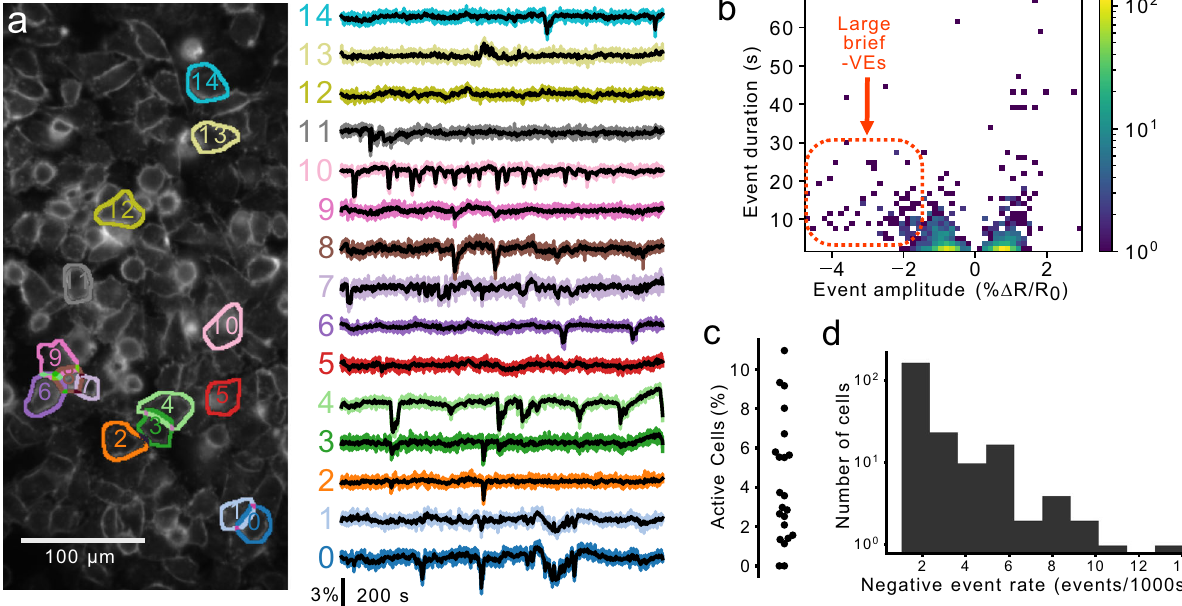
Fig. 3 A subset of MDA-MB-231 cells exhibit V m fl uctuations. a The ratio of Di-4-AN(F)EP(F)PTEA fl uorescence ( Δ R / R 0 ) was imaged at 5 frames/s in cultured MDA-MB-231 cells. The Δ R / R 0 time series extracted from the segmented cells (right) reveals heterogeneous V m fl uctuations consisting primarily of transient hyperpolarizations. b A log-scaled 2D histogram of event amplitude and duration. These fl uctuations vary in their polarity (positive-going, " + VE ’’ vs. negative-going " − VE ’’ ), amplitude, and duration. Large amplitude fl uctuations were typically hyperpolarising ( − VE amplitude) and short in duration. c Proportion of active cells for 20 technical replicates displaying the high variability in the proportion of active cells. d A log-scaled histogram of the mean − VE rate for all active cells (at least one − VE observed) showing the long-tailed distribution with a few highly active